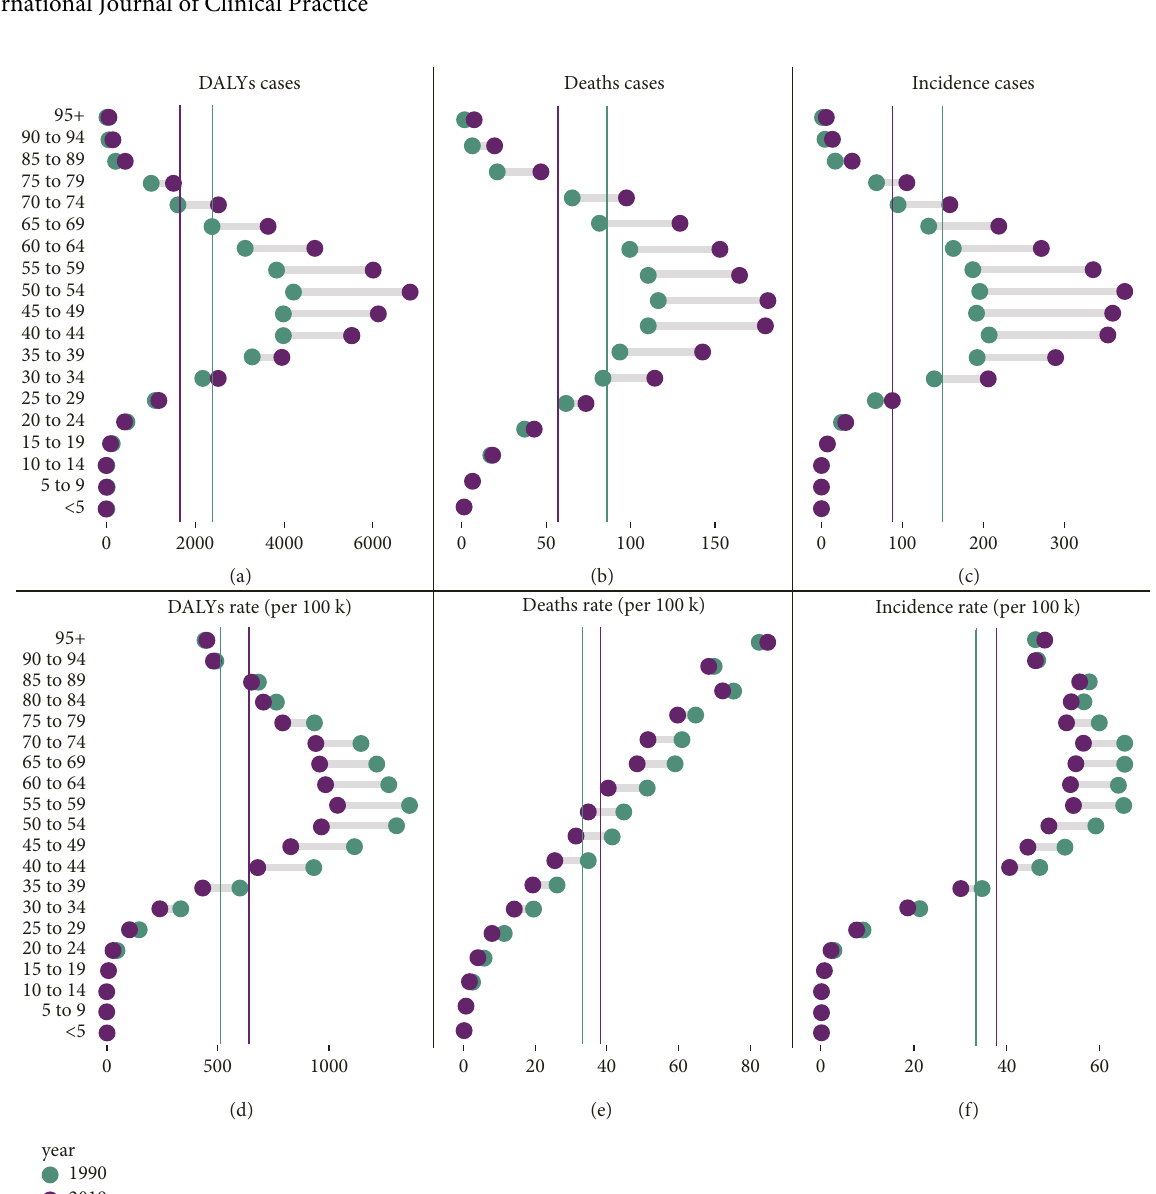
Figure 5: Incidence, death, and DALY rates of cervical cancer in different age